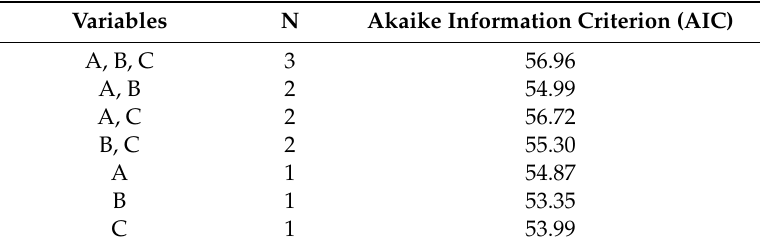
Table 1. Evaluation of logistic regression models for predicting flash floods. Variables